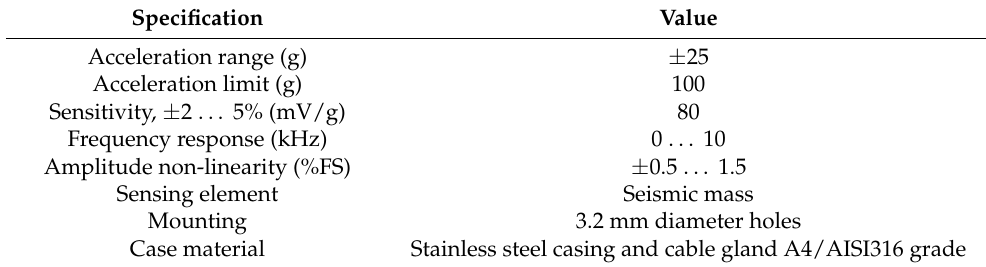
Table 1. Technical specifications of Micromega accelerometer [7].